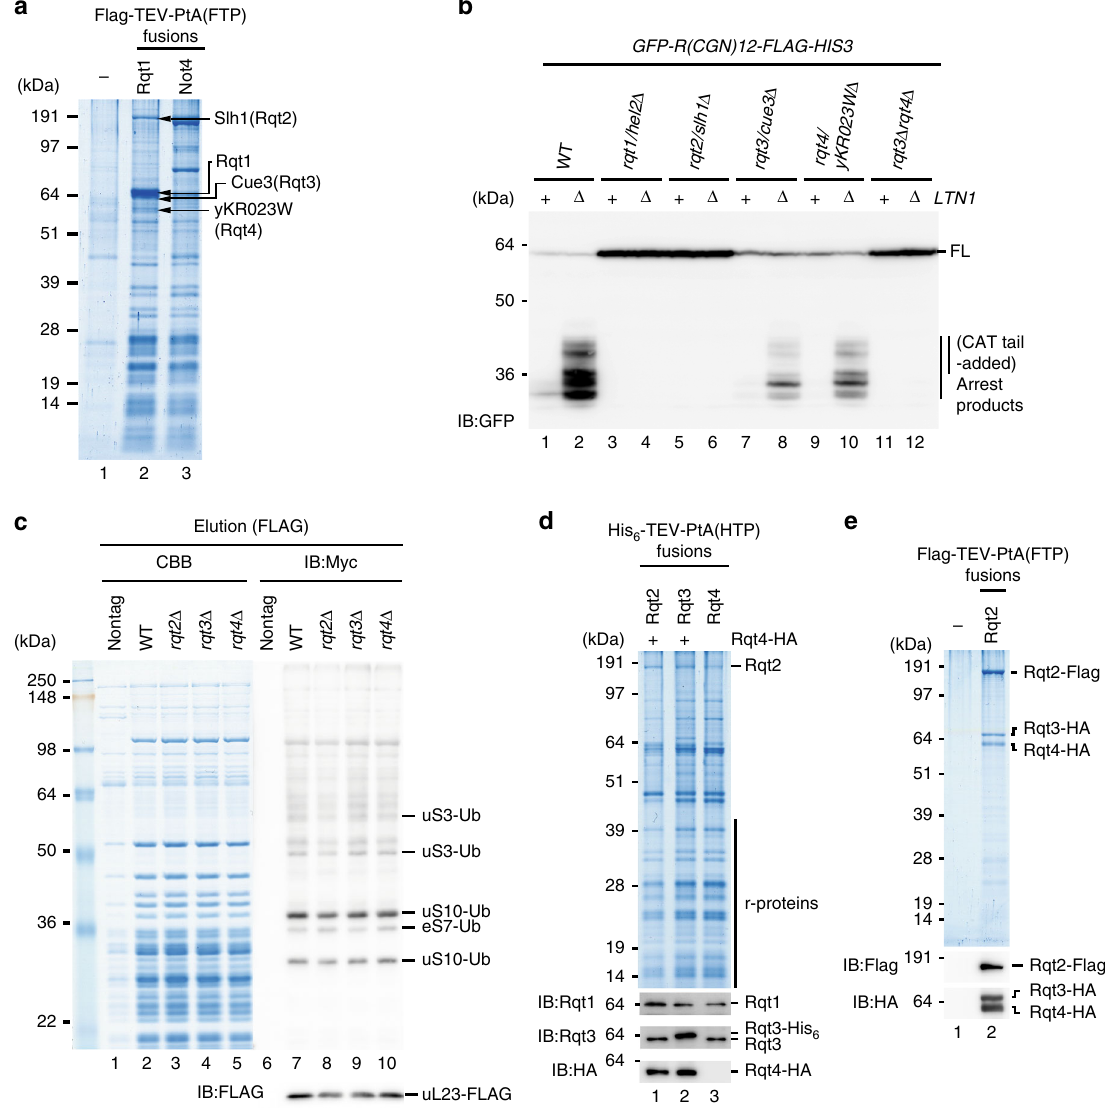
Fig. 2 RQC requires three novel ribosome-quality control trigger factors (RQT). a Identi fi cation of RQT factors. Puri fi ed Rqt1-ribosome complex were analyzed by SDS-PAGE. Arrowed proteins were identi fi ed by mass spectrometry. b RQT factors played a crucial role in triggering step of RQC pathway. c Rqt2, Rqt3, and Rqt4 were dispensable for the ubiquitination of ribosome proteins by Rqt1. d Af fi nity puri fi cation of Rqt2-, Rqt3-, and Rqt4-ribosome complexes. e Rqt2, Rqt3, and Rqt4 formed a complex independent of